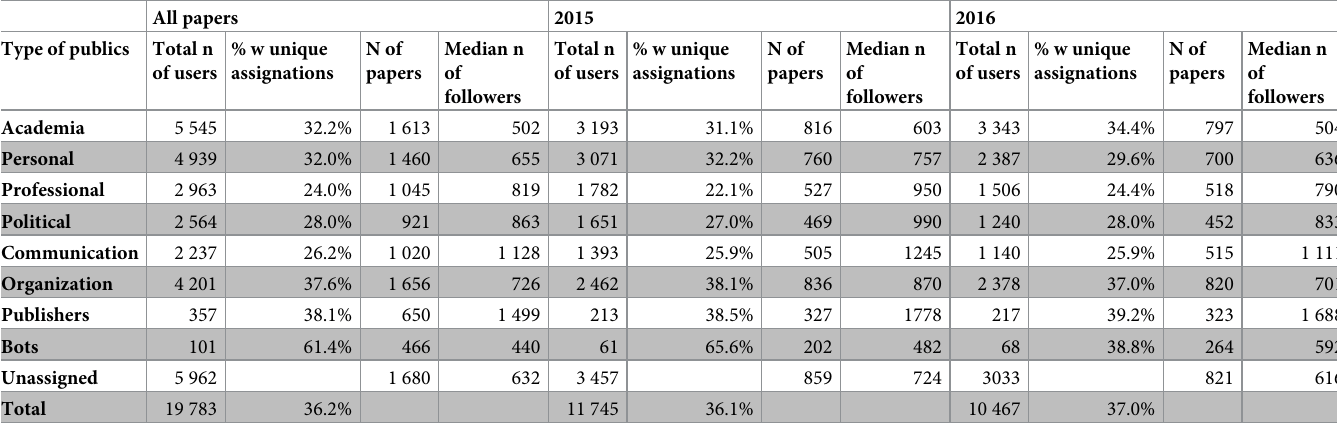
Table 2. Summary of results across all